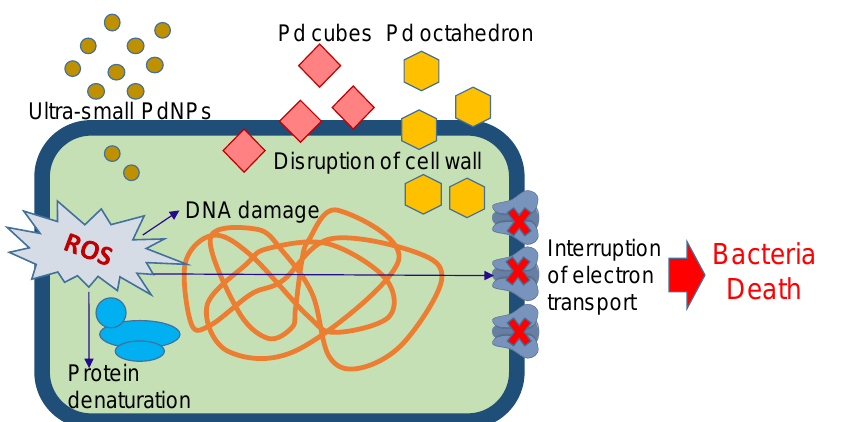
Figure 1. Illustration of the antibacterial mechanism of palladium nanoparticles (PdNPs). The facet of a Pd nanocrystal is able to disrupt the membranes of microorganisms. PdNPs are capable to generate the reactive oxygen species (ROS), which cause cell membrane damage, DNA damage, protein denaturation, and interruption of electron transport, resulting in the death of bacteria.